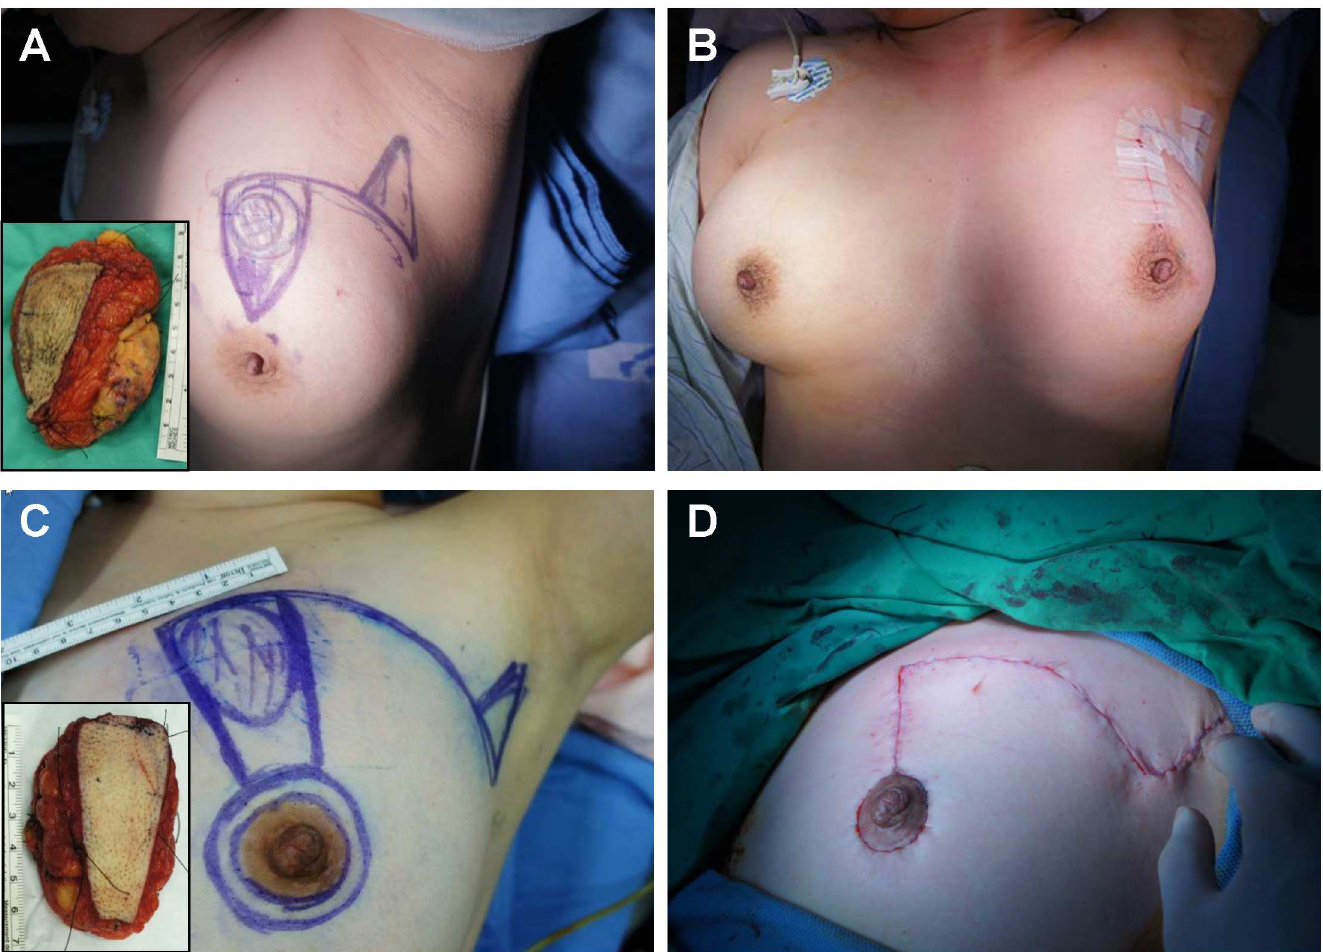
Fig 2. Patients were divided into either the non-donut or donut group, depending on the distance between the tumor and NAC. (A, B) A representative case of the non-donutgroup. The tumor was located 3 cm away from NAC. The patient underwentmatrix rotation without de- epithelialization. The specimenmeasured10 × 7.5 cm and weighed126 g. (C, D) Patient with a tumor locatedat the 10 o’clock position underwent matrix rotation with de-epithelialization. Preoperative drawingwith postoperative scar. The specimenmeasured7 × 4.5 cm and weighed56 g.